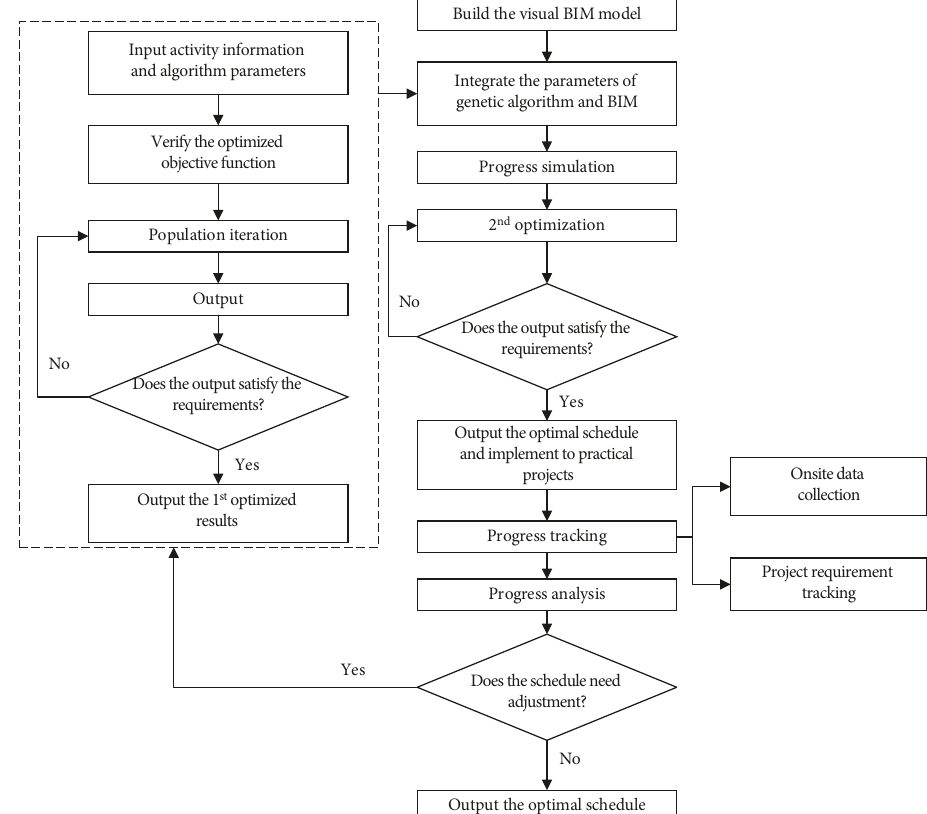
Figure 5: Dynamic schedule optimization and control based on GA and BIM.